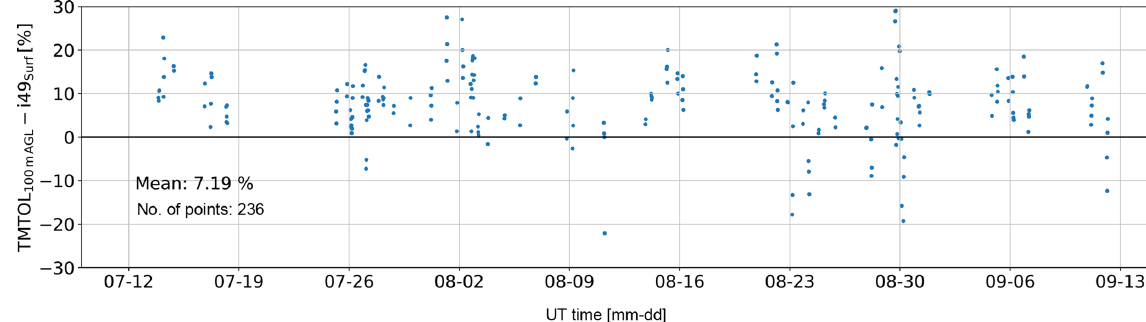
Figure 13. Relative difference between the first valid lidar data point (100ma.g.l.) and the co-located i49 surface ozone meter for the period between 13 July and 12 September 2018. Each point corresponds to a 30min